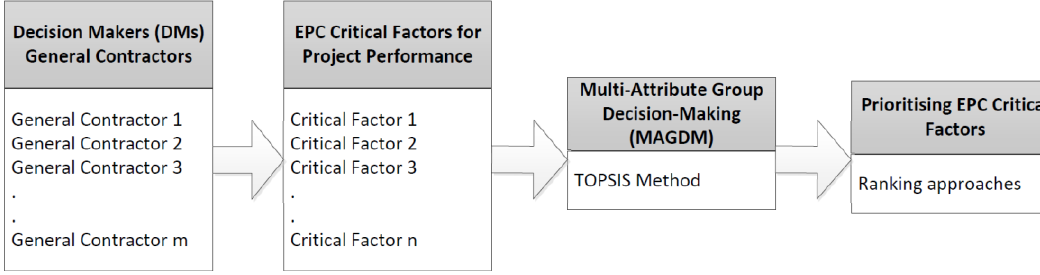
Table 2. Attributes and Initial Measurement indicators.